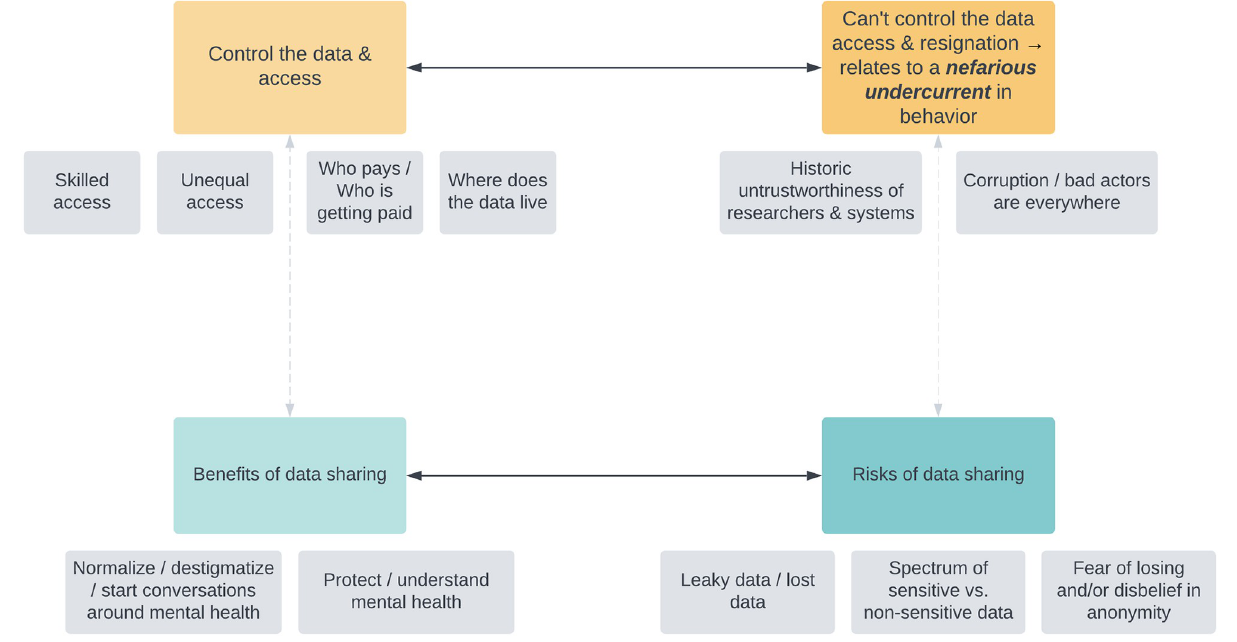
Fig 7. Analytical framework of emergent themes and tensions derived from public deliberation